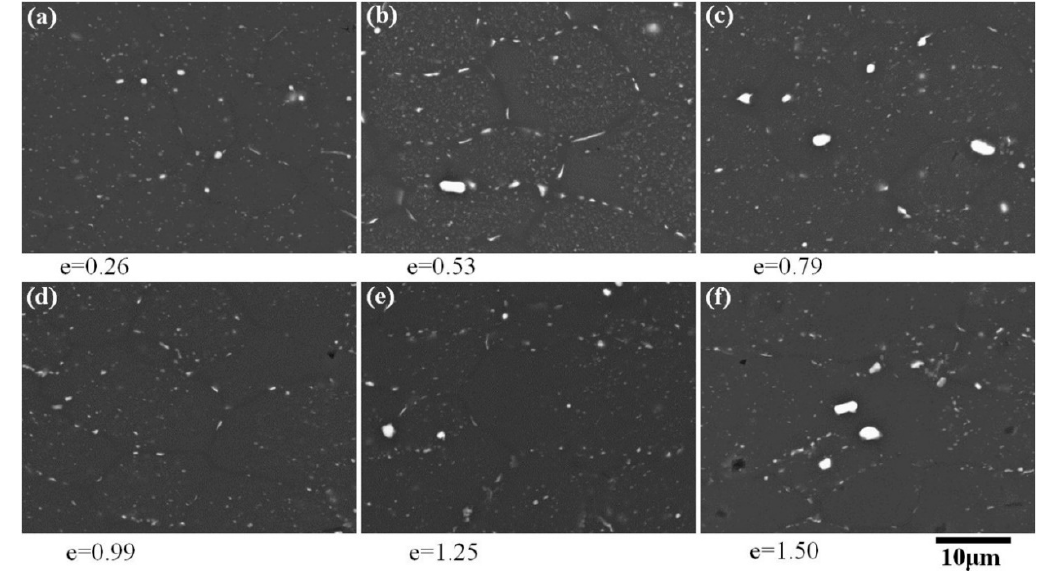
Figure 5. SEM backscattered electron images after superplastic deformation at 490 °C and 2 × 10 − 4 s − 1 . The evolution of the HAADF-STEM structure during superplastic deformation is shown